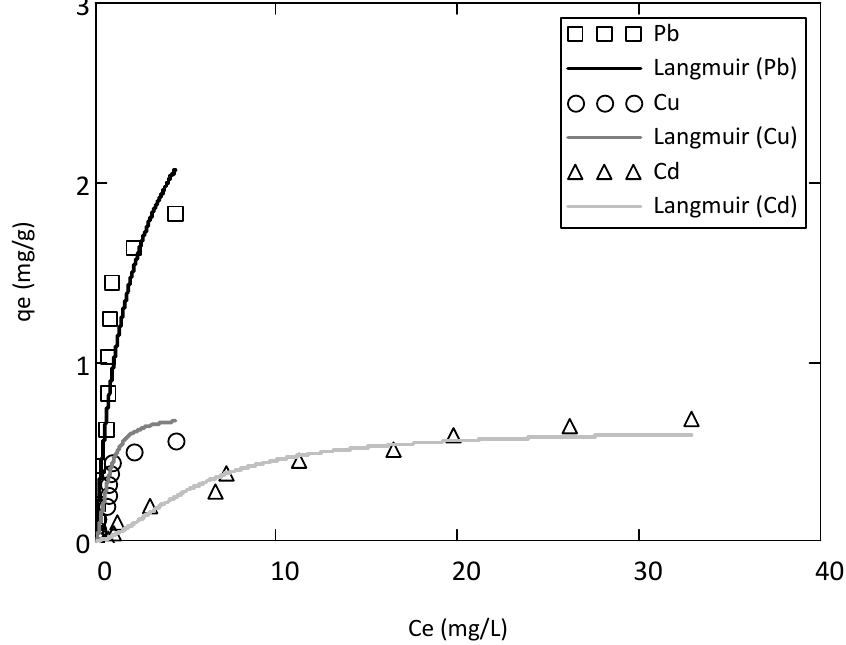
Figure 4. Langmuir adsorption model for Pb 2+ , Cu 2+ and Cd 2+ on the studied soil at pH